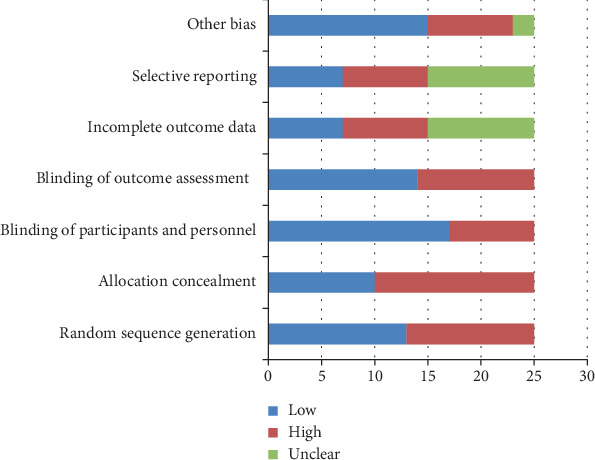
Risk of bias graph.